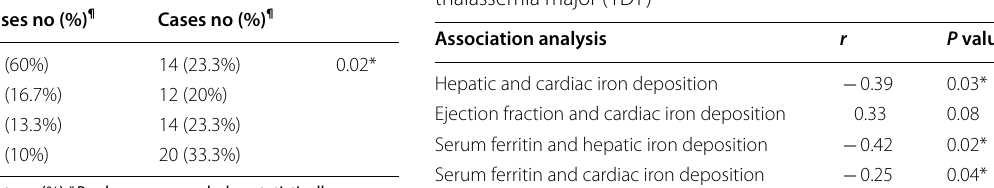
Table 2 Iron overload severity in liver and heart according to T2* in children with transfusion-dependent beta-thalassemia major